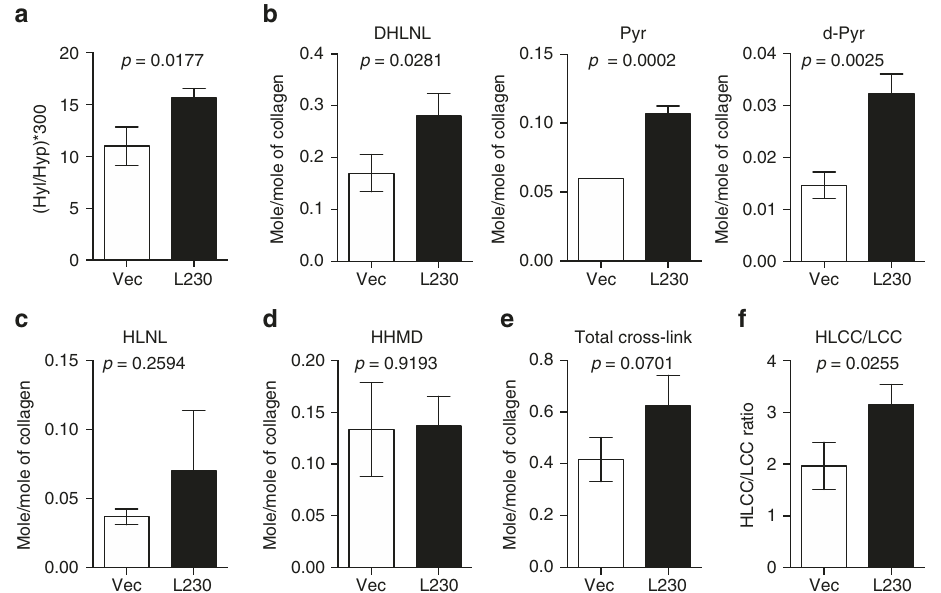
Fig. 4 L230 induces a collagen cross-link switch in tumor stroma. Collagen cross-links (mol mol − 1 of collagen) in orthotopic lung tumors generated by injection of nude mice with H1299 cells stably transfected with empty vector (Vec) or full-length L230 (L230) ( n = 3 tumors in each cohort). Quanti fi cation of a collagen Hyl content calculated as the product of 300 times the mean Hyl values divided by mean hydroxyproline (Hyp) values; b the HLCCs DHLNL, Pyr, and d-Pyr; c HLNL; and d the LCC HHMD. e Total collagen cross-links represent the sum of cross-links in b – d . f HLCC-to-LCC ratio was calculated as the sum of HLCC mean values (DHLNL + Pyr + d-Pyr) divided by LCC (HHMD) mean values. HLNL was excluded from the analysis because it can be classi fi ed as LCC or HLCC depending on its derivation. Results are mean values ( ± S.D.) from triplicate biological samples. p values, two-tailed Student ’ s